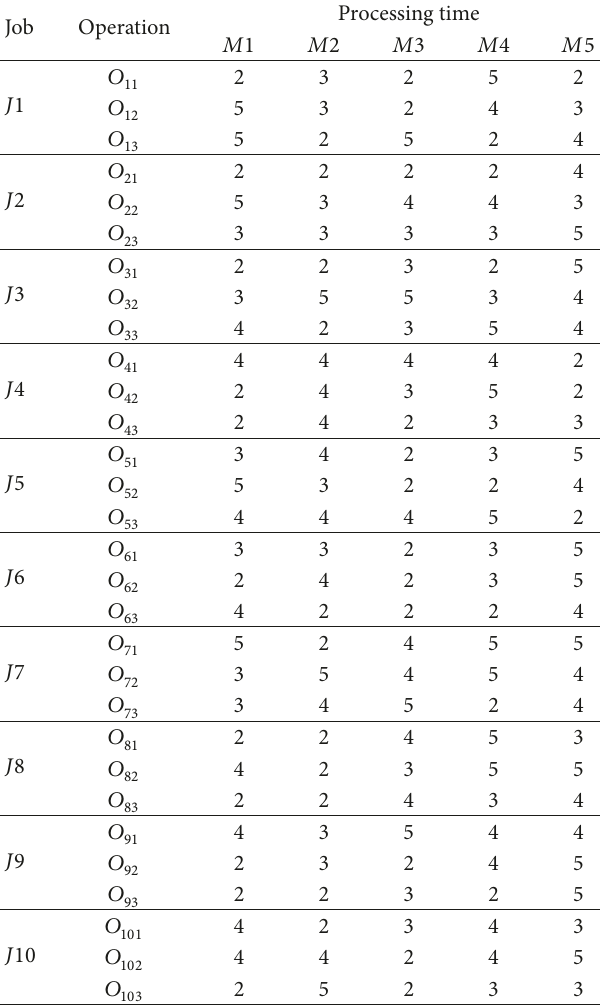
Table 2: Processing information of FJSP with 10 jobs and 5